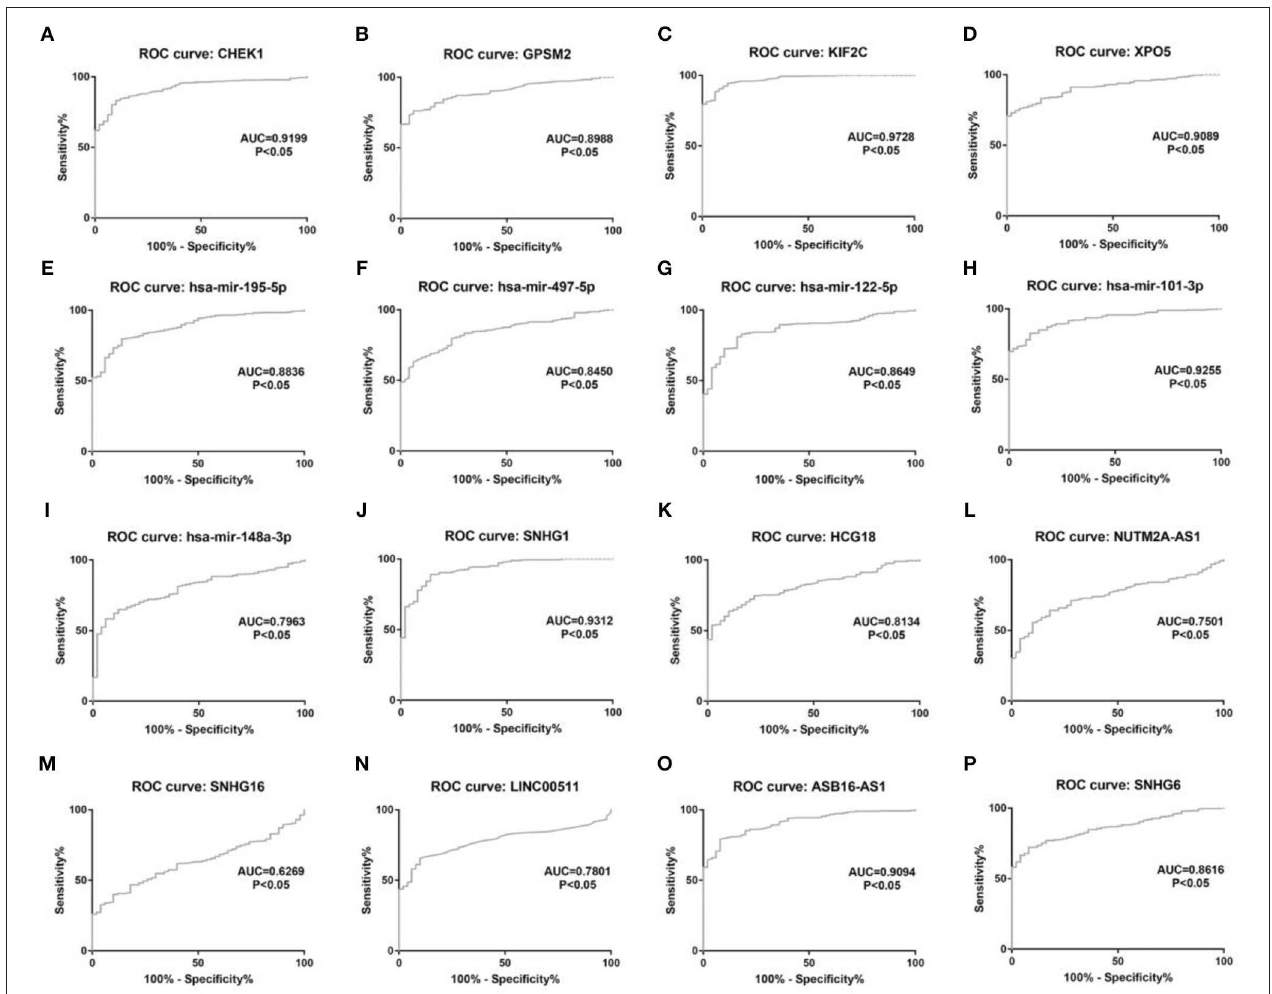
FIGURE 11 | The diagnostic values of 16 potential molecules in hepatocellular carcinoma. (A) CHEK1 ROC analysis in hepatocellular carcinoma; (B) GPSM2 ROC analysis in hepatocellular carcinoma; (C) KIF2C ROC analysis in hepatocellular carcinoma; (D) XPO5 ROC analysis in hepatocellular carcinoma; (E) hsa-mir-195-5p ROC analysis in hepatocellular carcinoma; (F) hsa-mir-497-5p ROC analysis in hepatocellular carcinoma; (G) hsa-mir-122-5p ROC analysis in hepatocellular carcinoma; (H) hsa-mir-101-3p ROC analysis in hepatocellular carcinoma; (I) hsa-mir-148a-5p ROC analysis in hepatocellular carcinoma; (J) SNHG1 ROC analysis in hepatocellular carcinoma; (K) HCG18 ROC analysis in hepatocellular carcinoma; (L) NUTM2A-AS1 ROC analysis in hepatocellular carcinoma; (M) SNHG16 ROC analysis in hepatocellular carcinoma; (N) LINC00511 ROC analysis in hepatocellular carcinoma; (O) ASB16-AS1 ROC analysis in hepatocellular carcinoma. (P) SNHG6 ROC analysis in hepatocellular carcinoma. ROC, receiver operating characteristic. P < 0.05 was considered as statistically significant.